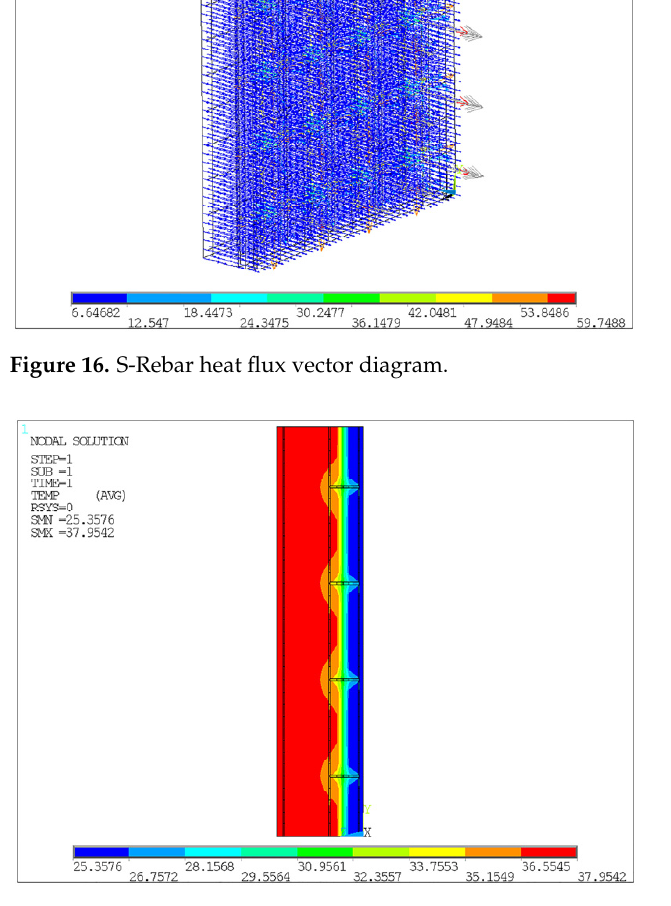
Figure 17. S-Rebar temperature contour of the section. Note: X, Y, and Z are the directions of the coordinates.